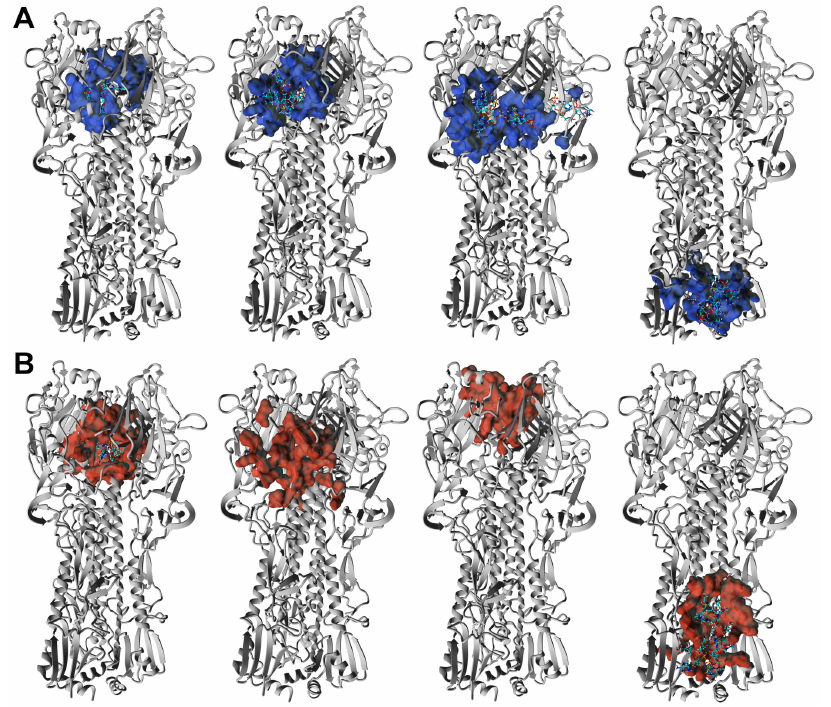
Figure 8. 3D structure of the four lowest energy complexes of the HA3 with A6-ORNs ( A ) and A6-ORNs-D-M ( B ) ligands. The hemagglutinin epitops involved in interactions with A6-ORNs and A6-ORNs-D-M are highlighted as blue and red,